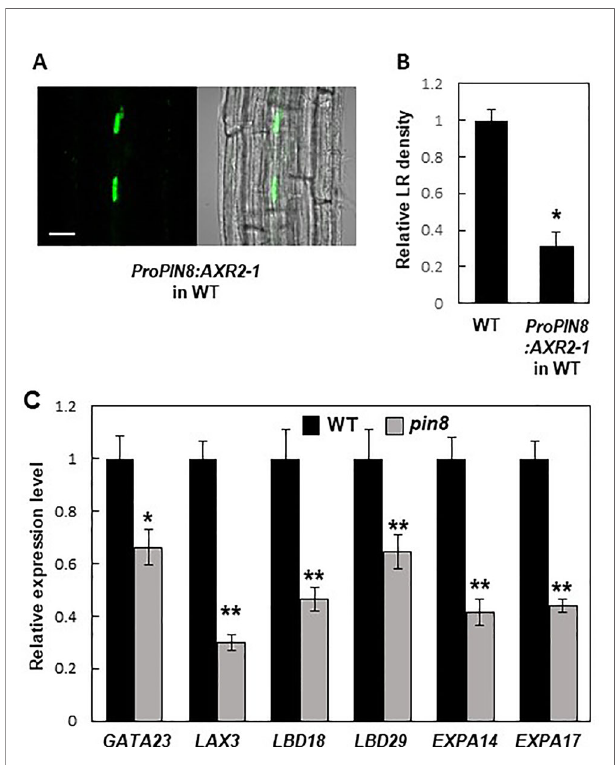
FIGURE 6 | Auxin signaling in the PIN8 domain is required for lateral root (LR) development. (A) Confocal images [ fl uorescence (left) and bright fi eld (right)] showing the AXR2-1:GFP signal in the PIN8 domain of the root. Scale bar = 20 µm. (B) LR densities of the wild type (WT) and ProPIN8:AXR2-1: GFP transgenic line. Data represent mean ± SE [ n = 35 – 36; from 3 independent lines for ProPIN8:AXR2-1:GFP ( Supplementary Figure S9C )]. Signi fi cant differences compared with the WT are indicated using an asterisk (* P < 10 − 9 ; Student's t -test). (C) Relative transcript levels of LR-related genes in the WT and pin8 mutant. Data represent mean ± SE of three biological replications. Signi fi cant differences compared with the WT are indicated using asterisks (* P < 0.05, ** P < 0.01; Student's t